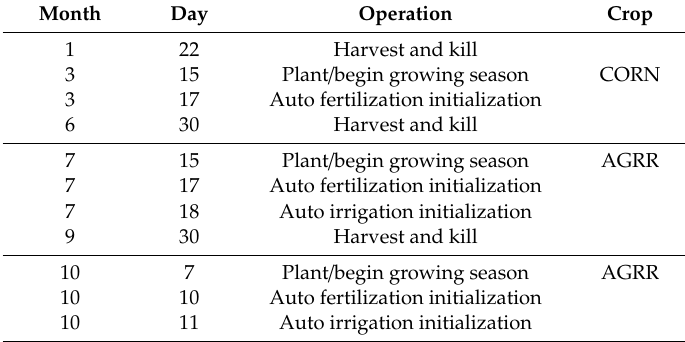
Table 4. Operations schedule for the rainfed maize to irrigated mixed crops to irrigated mixed crops trajectory in SWAT.